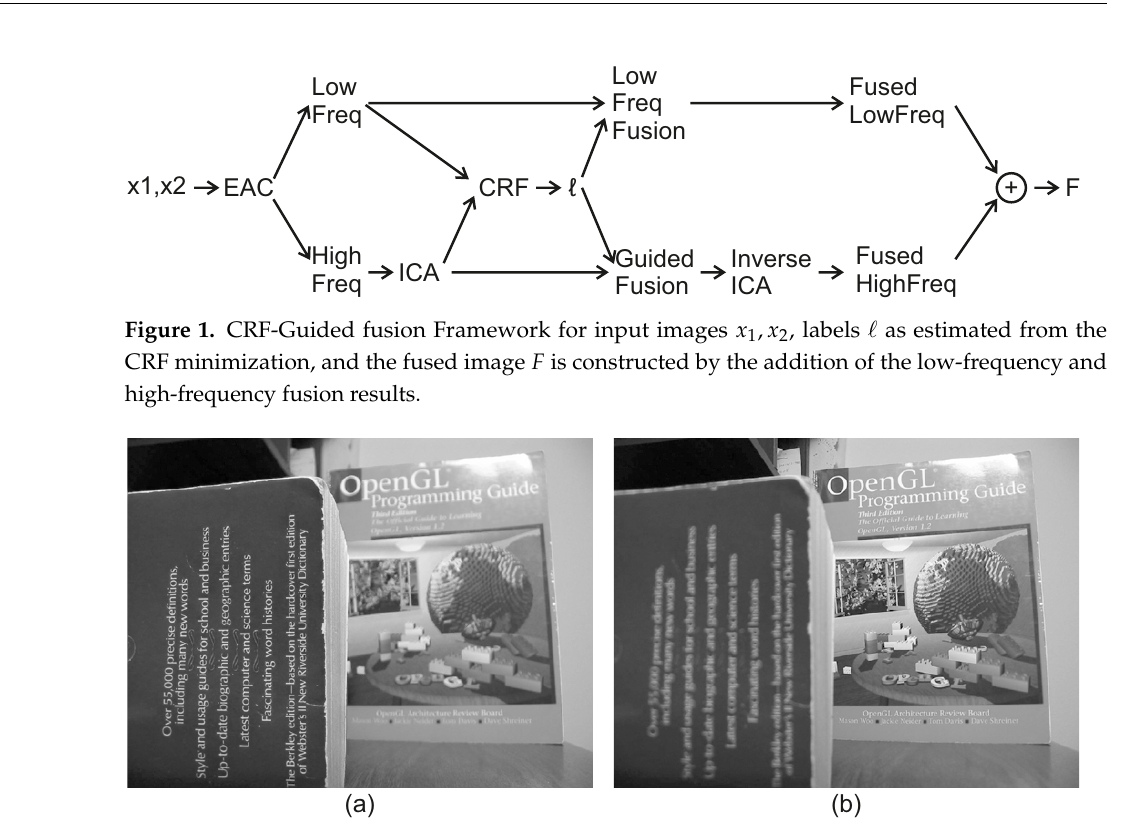
Figure 2. Source input images: ( a ) Near focused image, ( b ) Far focused